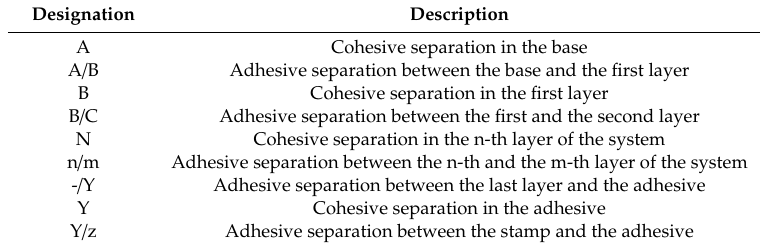
Table 6. Pull-o ff test classification according to the norm PN–EN ISO 4624:2016 [25].